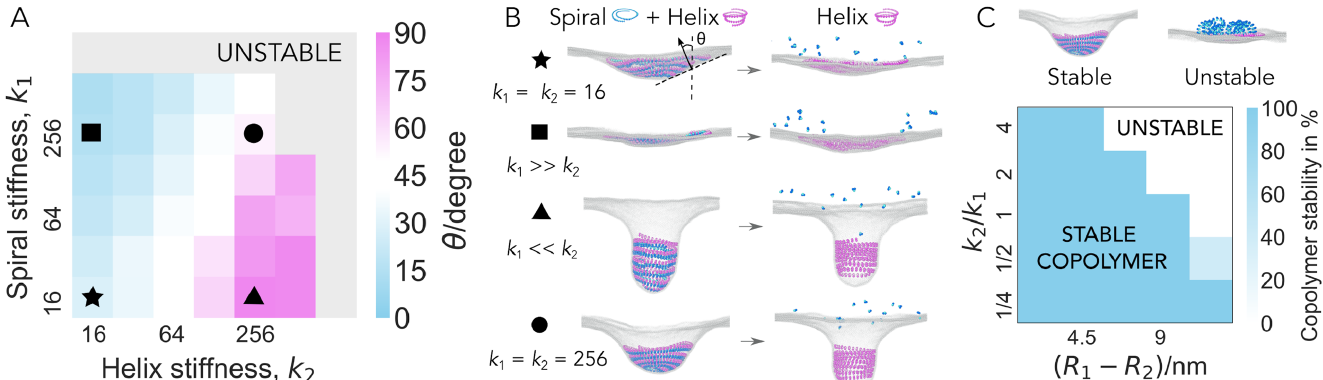
Fig 2. Relative filament stiffness controls the membrane deformation. A: Membrane deformation as a function of the stiffness of the Flat Spiral ( k 1 ) and the Wide Helix ( k 2 ), ( k 1 , k 2 are in units of k B T / σ 2 , σ is the MD unit of length, σ = 2.3 nm). The membrane deformation angle θ is characterized by the angle between the vertical axis (normal to the original flat membrane plane) and the membrane normal at half depth of the deformation, as illustrated in the first snapshot in panel B. θ = 0˚ when the membrane is flat and θ = 90˚ when the membrane forms a tubule. Conical membrane deformations lie in between. The membrane deformation angle is calculated from the average of five independent runs. B: Representative simulation snapshots before and after the disassembly of the Flat Spiral, obtained for representative parameter sets as indicated by the matching labels in A. C: Copolymer stability as a function of the mismatch in the radius and ratio of stiffness between the Wide Helix and the Flat Spiral. Copolymer stability is quantified by a proportion of simulations in which the copolymerizing filaments remain attached to the membrane. The Flat Spiral is fixed at target radius R 1 = 19.4 nm with filament bond stiffness k 1 = 128 k B T / σ 2 . All data points are averaged over ten simulations.